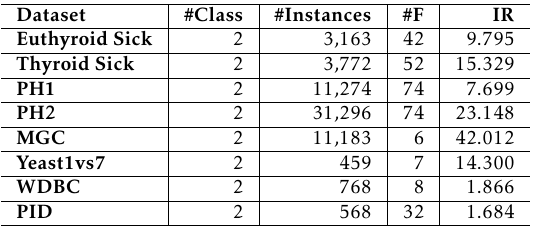
Table 4. Characteristics of Used Healthcare Datasets Dataset